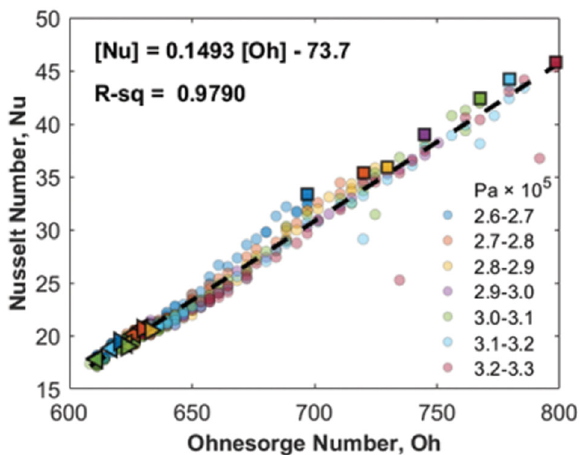
Fig. 10 Nusselt number correlation. A universal correlation between the Nusselt number and Ohnesorge number. Special markers share the same de fi nition as in Fig.